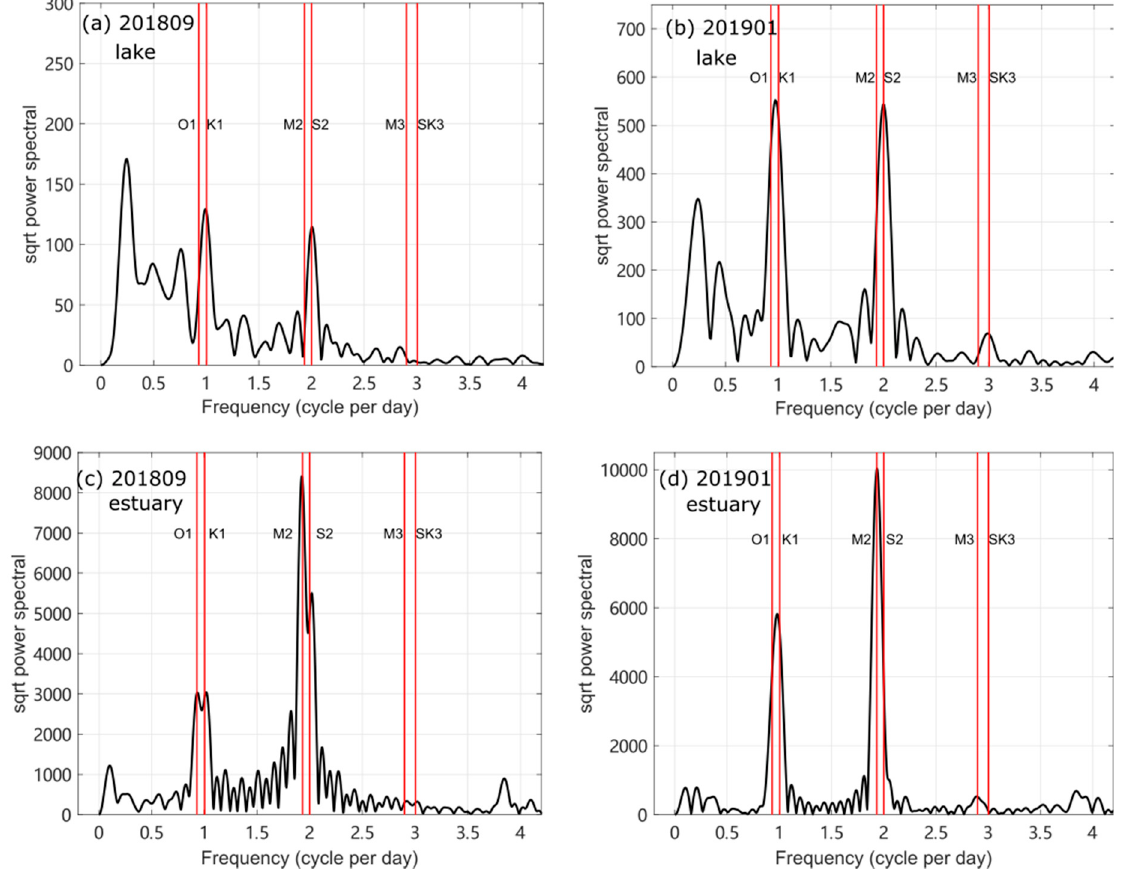
Figure 4. Power spectra of surface water levels in the lake in ( a ) September 2018, ( b ) January 2019, and power spectra of sea level anomalies in the open channel in ( c ) September 2018 and ( d ) January 2019. Red lines indicate tidal frequencies as in Figure 3b.